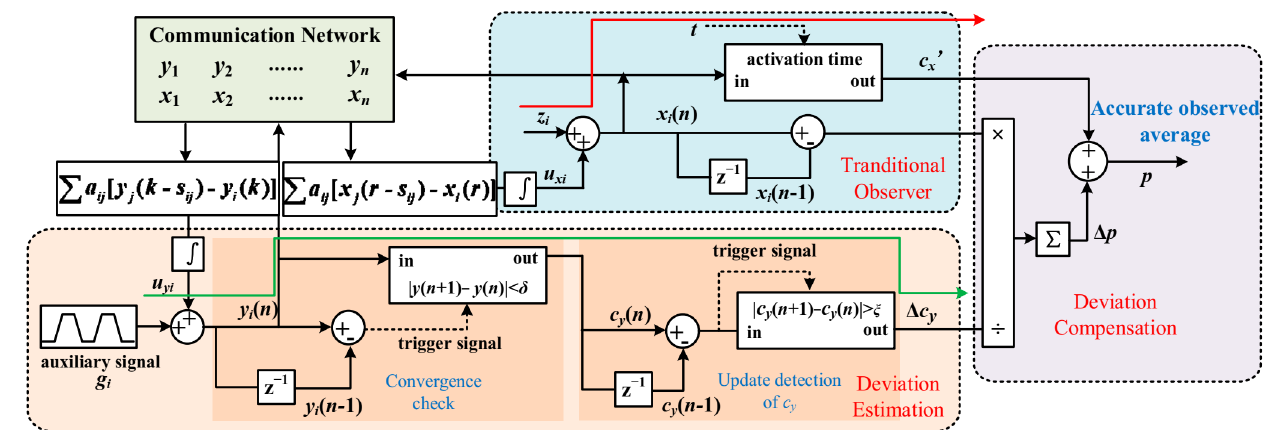
Figure 5. Control diagram for the proposed dynamic consensus